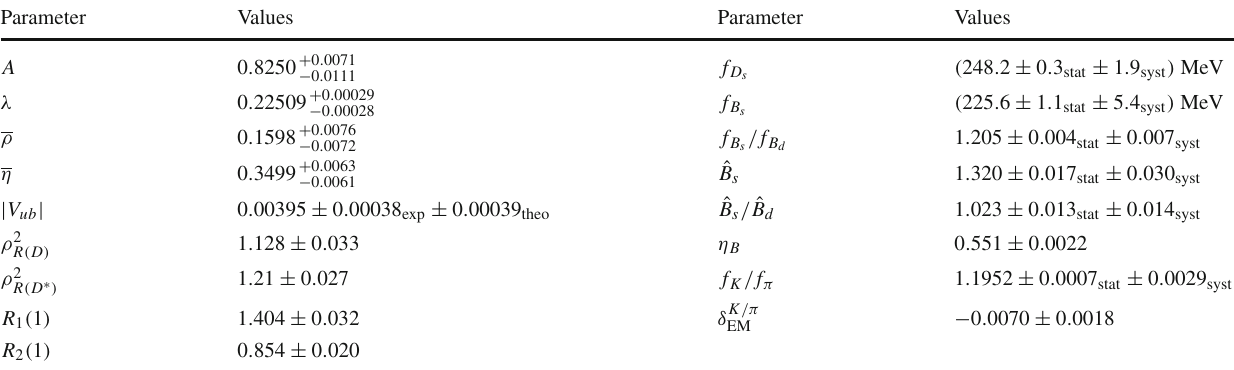
Table 3 Parameters used in the fit to the flavour observables. Most values are taken from latest available version of the CKM fit [141]. For the CKM matrix element | V ub | we use the average of inclusive and exclusive measurements [143], while all other CKM matrix elements